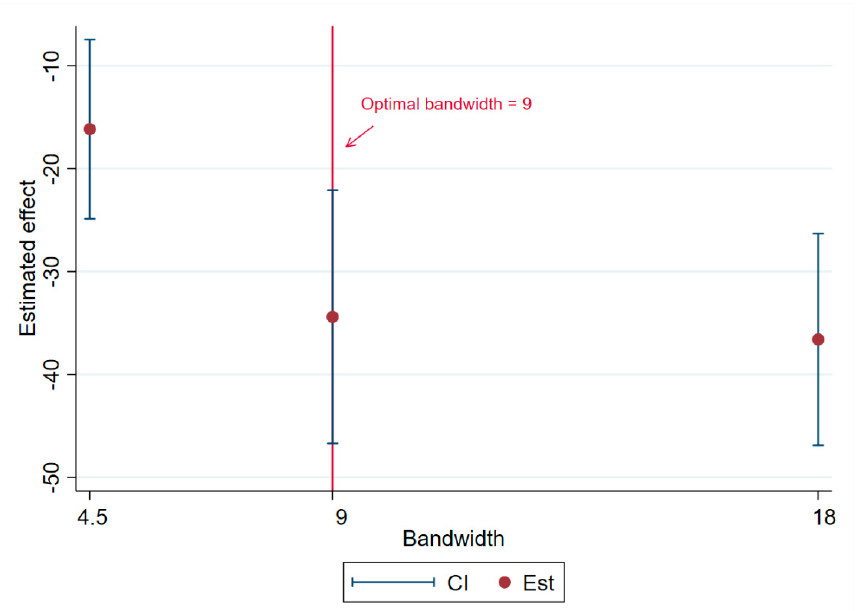
Figure 7. Bandwidth dependence when the fuzzy breakpoint is